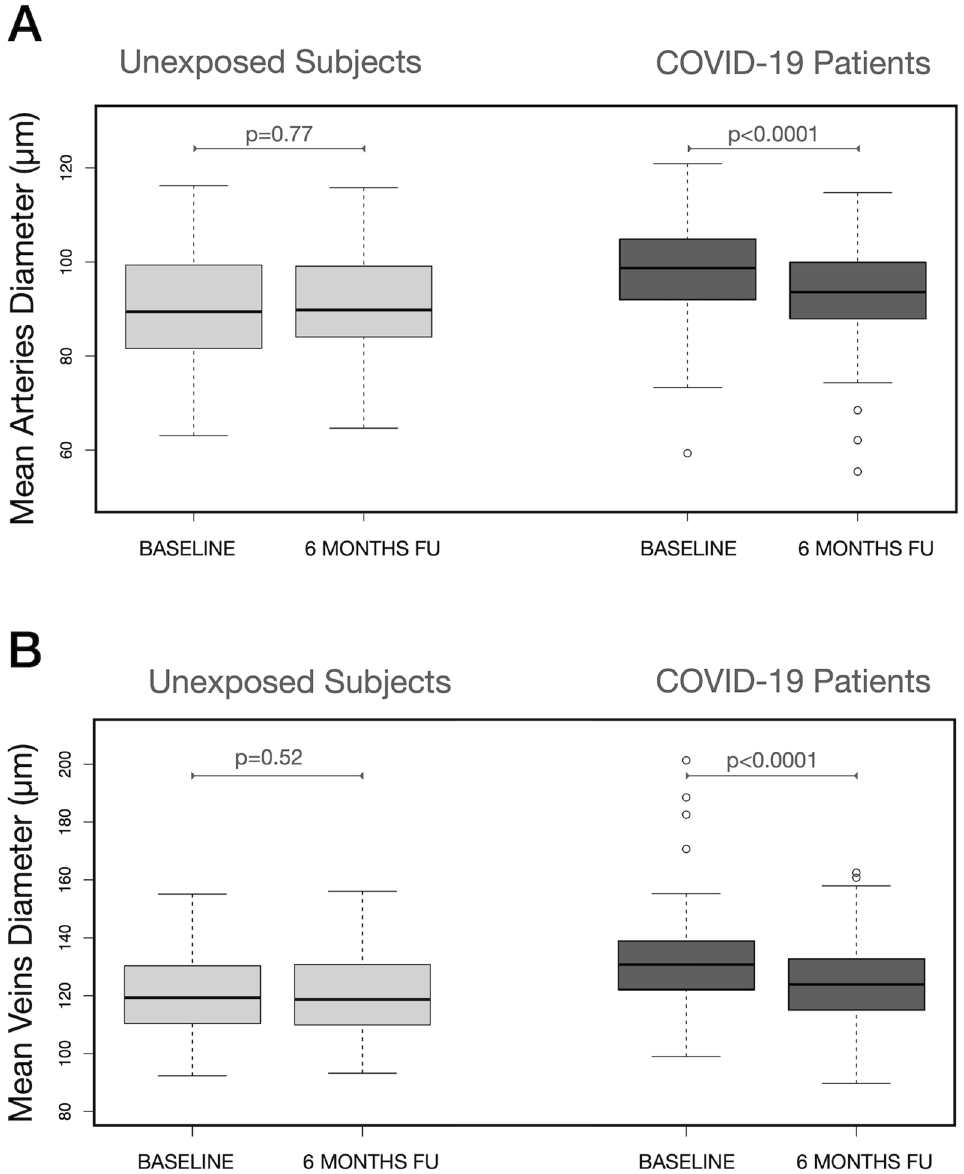
Figure 1. Mean Arteries diameter (MAD) and mean veins diameter (MVD) in COVID-19 patients and subjects unexposed to the SARS-CoV-2 virus at baseline and 6 months later: within groups comparison. Arteries ( A ) and veins ( B ) did not change in diameter from baseline to follow-up in subjects unexposed to the virus. By contrast both MAD ( A ) and MVD ( B ) significantly decreased from baseline to 6 months follow-up in patients who suffered from COVID-19. Reported p values were obtained by linear mixed model for repeated measurements accounting for nesting of eyes within